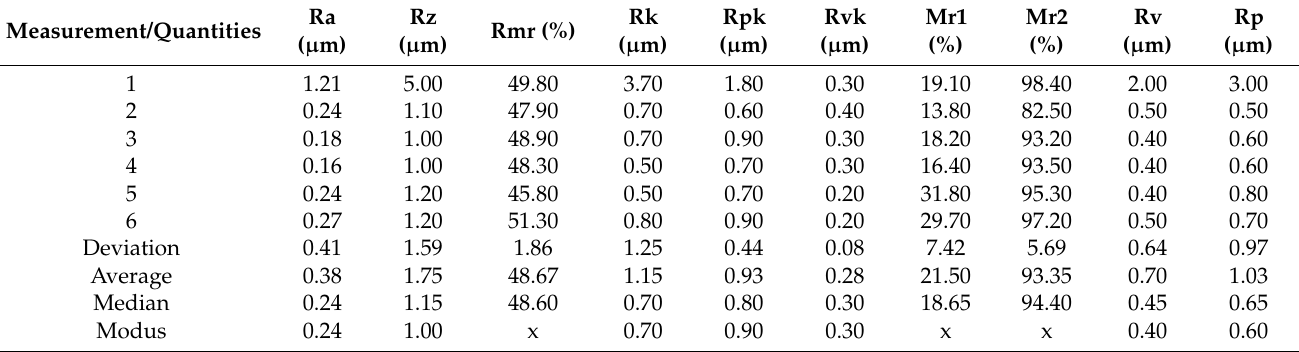
Table 4. Component